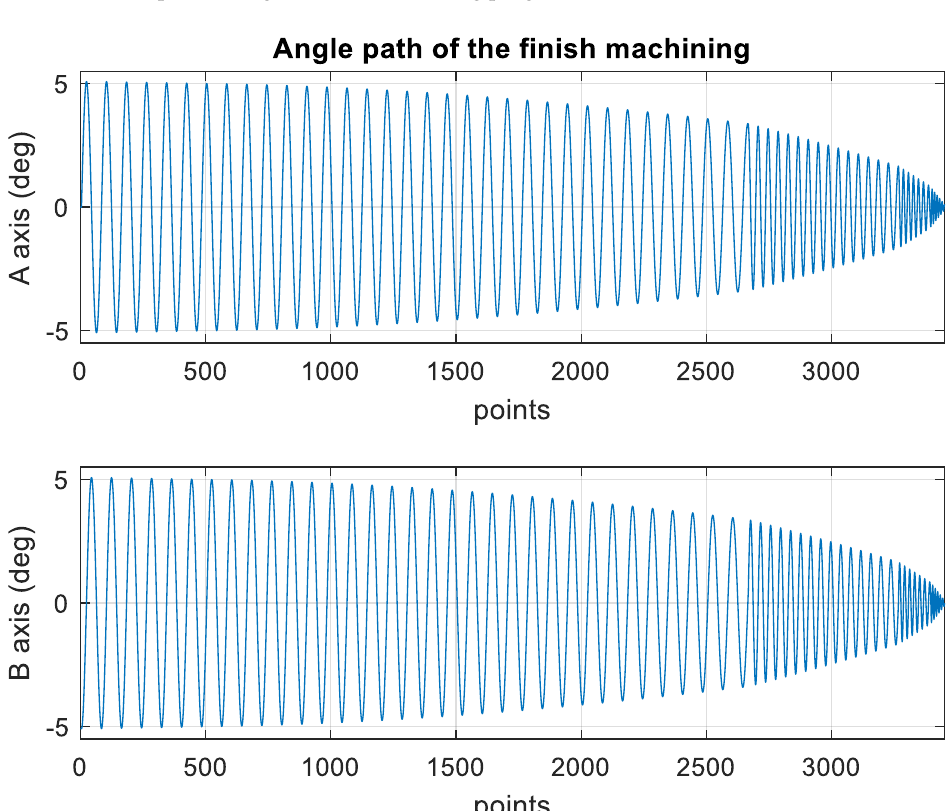
Figure 15. Angle path of the original finish machining program.